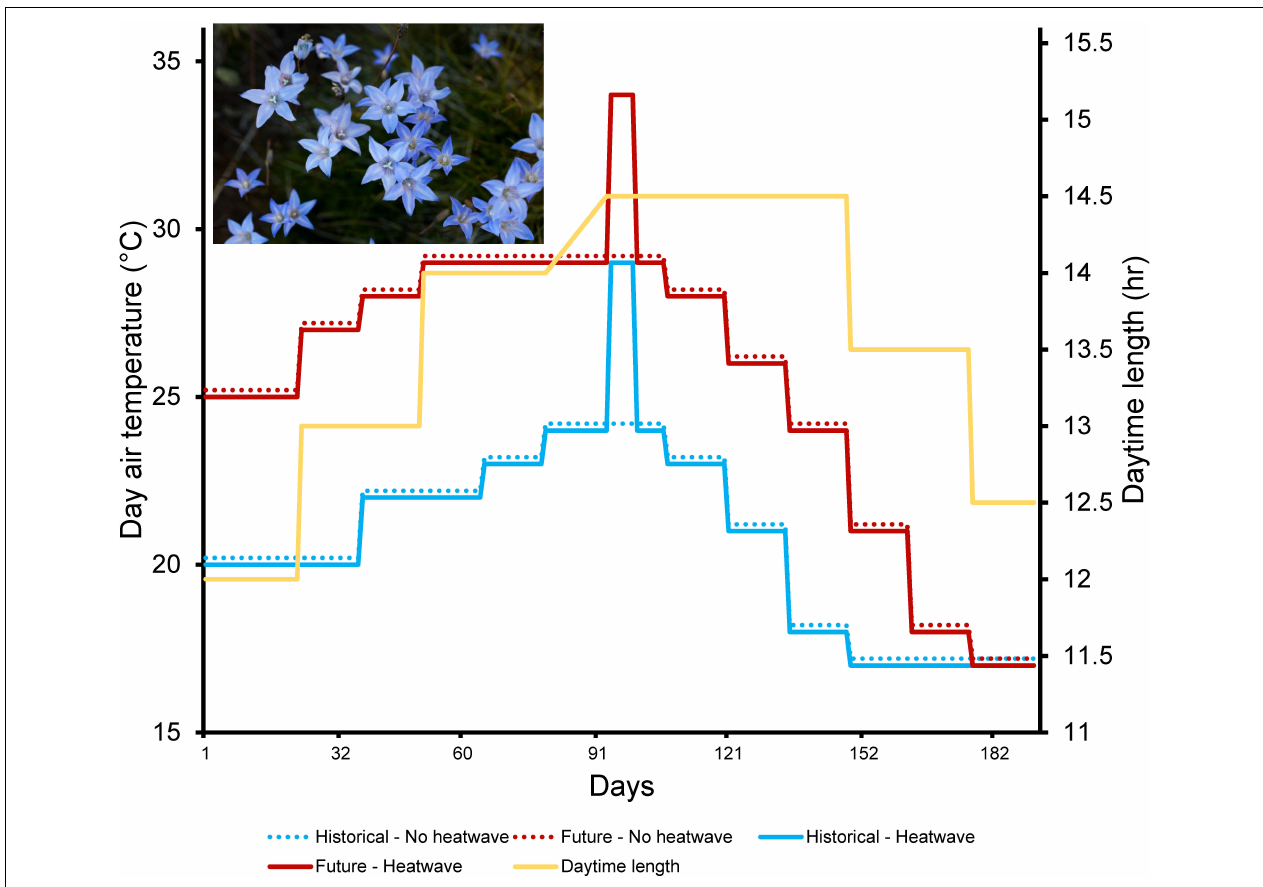
FIGURE 1 | Day temperatures and photoperiod across the duration of the experiment. Toward the middle of summer individuals were exposed to a 5-day heatwave treatment (solid lines), while control individuals remained under constant conditions of a historical and future scenario (dotted lines). Light blue = historical climate scenario; red = future climate scenario; yellow = photoperiod. To ease the view of the lines, which would be otherwise overlapping, 0.2 ◦ C were added to the groups “Historical – No heatwave” and “Future – No heatwave” only for the purposes of drawing the graph. Inset: Wahlenbergia ceracea . Credit: T Hayashi, February 2015, Kosciuszko National